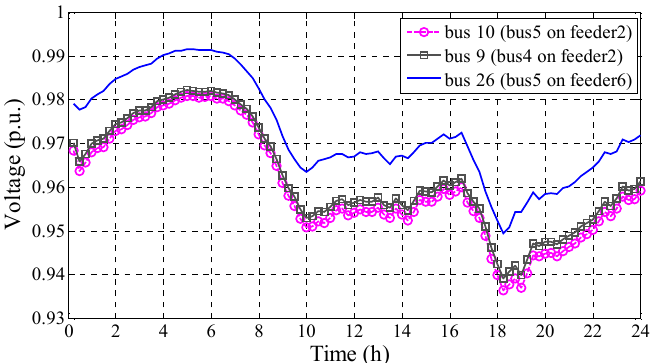
Figure 6. Voltage profile of grid critical buses (no photovoltaic (PV) panels and no PEV).